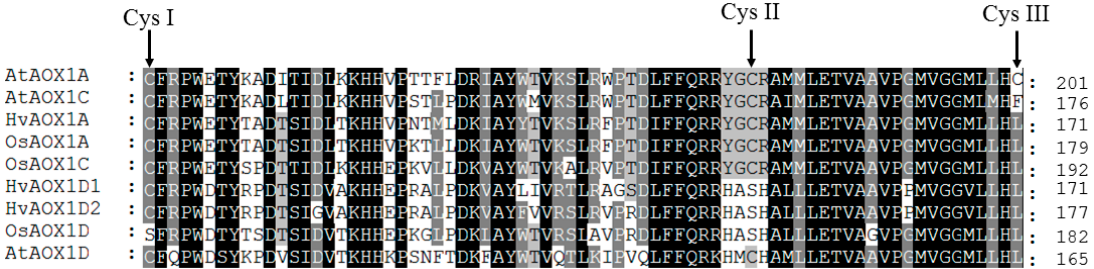
Figure 4. Alignment of a section of AOX isoforms in rice and barley. The amino acid sequences were aligned using the Clustal program. The region showing all the cysteine residues of these AOX proteins is shown. OsAOX1d has a serine at Cys 1 ; HvAOX1d1, HvAOX1d2 and OsAOX1d have a serine at Cys II ; all rice and